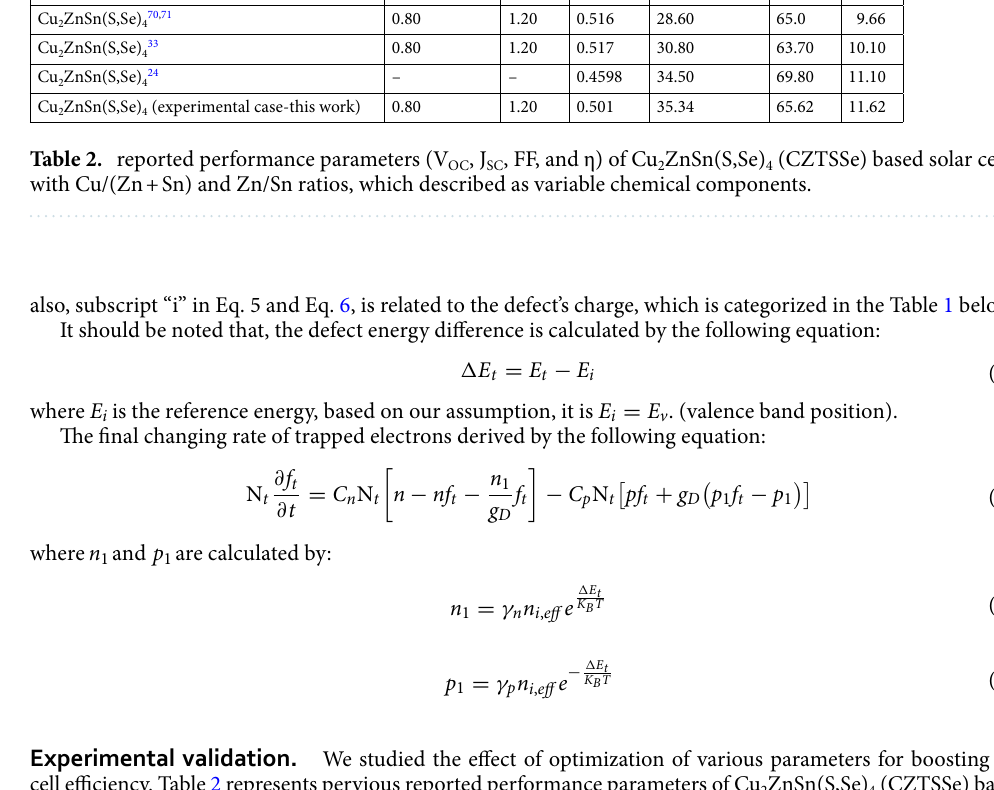
potential barrier on performance of the simulated cell, which is derived by: